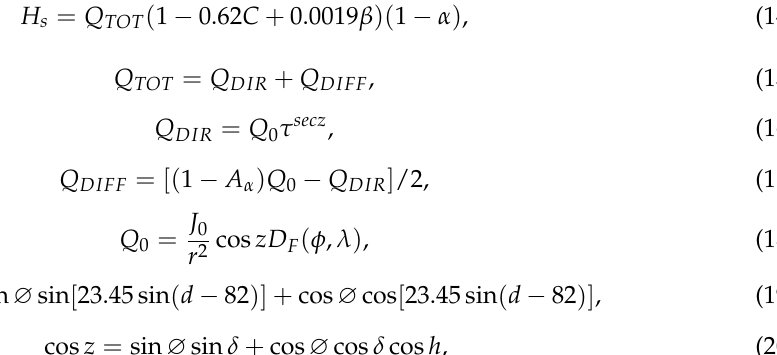
Figure 4. The flow at hydrological stations of Kaidu River (KDR), Huangshuigou (HSG), and Kongque River (KQR) used in driving the model of Bosten Lake during the study period from 00:00 1 April to 00:00 30 November 2005.